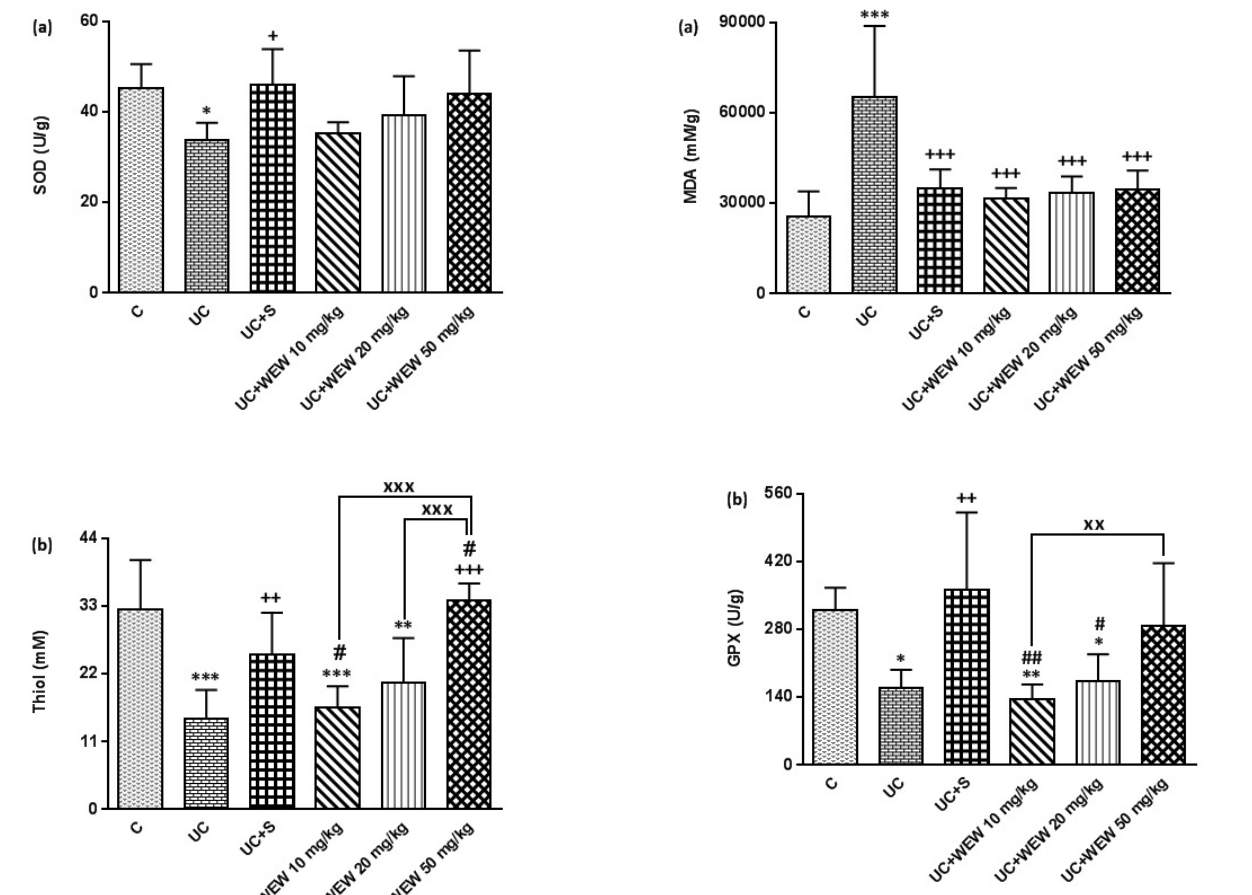
FIGURE 3 - MDA (a) and GPX (b) levels in the colon tissue of control (C), ulcerative colitis group (UC), ulcerative colitis rats treated with sulfasalazine (UC+S) and woody endocarpium of wulnut extract (UC+WEW), (n=7 in each group). Data are presented as mean ± SEM values. * p<0.05, ** p<0.01 and *** p<0.001 shows significant differences compared to group C. ++ p<0.01 and +++ p<0.001 show significant differences compared to group UC. # p<0.05 and ## p<0.01 shows significant differences compared to group UC+S. xx p<0.01 show significant differences between the three concentrations WEW. Statistical analyses were performed using ANOVA with Tukey-Kramer’s